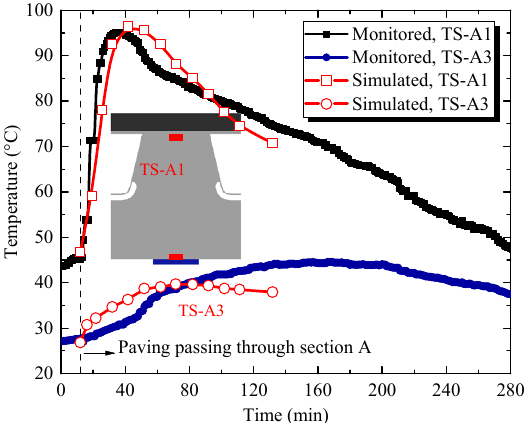
Figure 10. Comparison of monitored and numerical results of temperature.